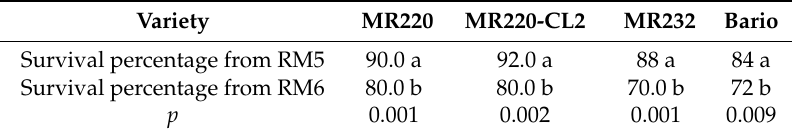
Figure S1: The morphology of calli on MS media of different concentrations of 2,4-D (1-4 mg/L) of (a) MR220 (b) MR220-CL2 (c) MR232 and (d) Bario, Figure S2: Establishment of MR220, MR220-CL2, MR232 and Bario plant through in vitro callus induction to ripening